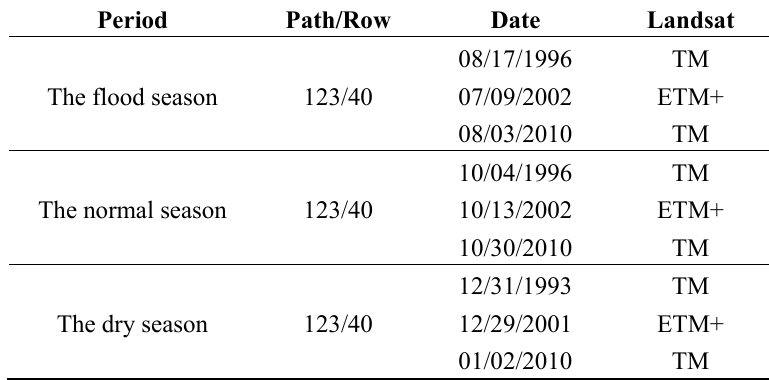
Table 2. Periods, paths, rows, acquisition dates, and sources of Landsat